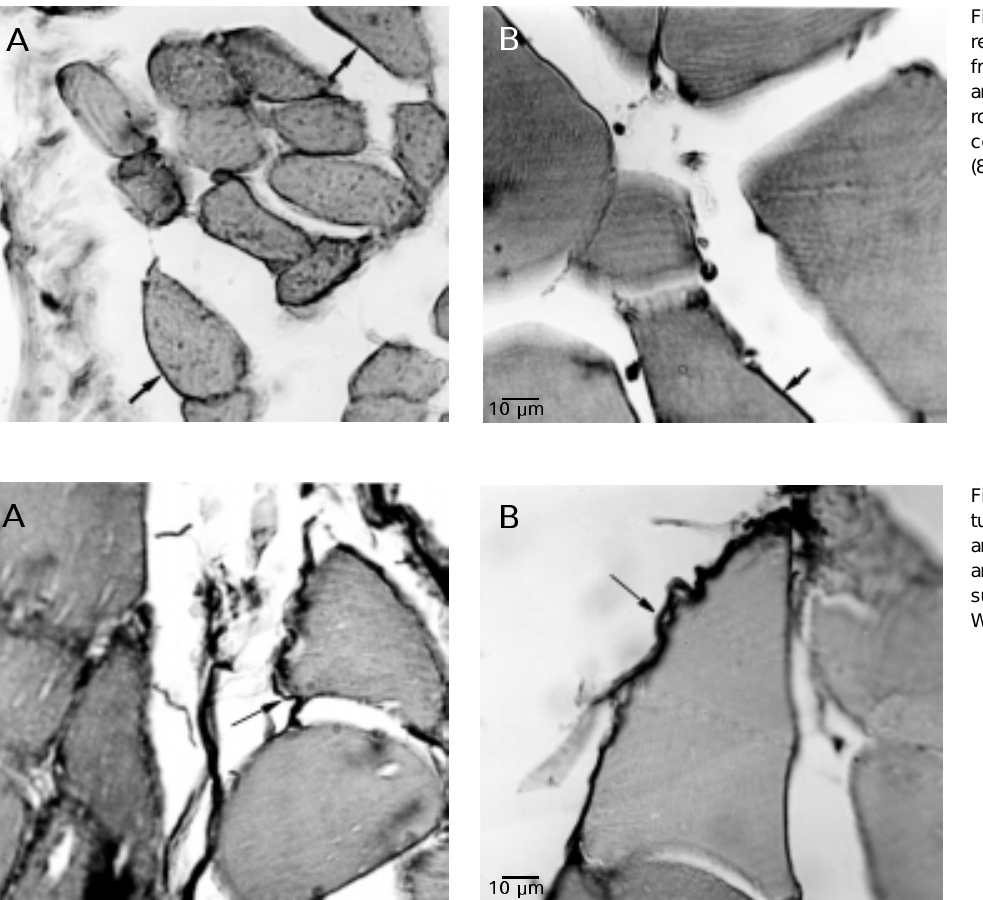
Figure 1 - Diaphragm (A) and rectus abdominis muscles (B) from a young (1 month) rat. Thin and straight elastic fibers (ar- rows) surrounding the muscle cells. Weigert-oxone stain (800X).